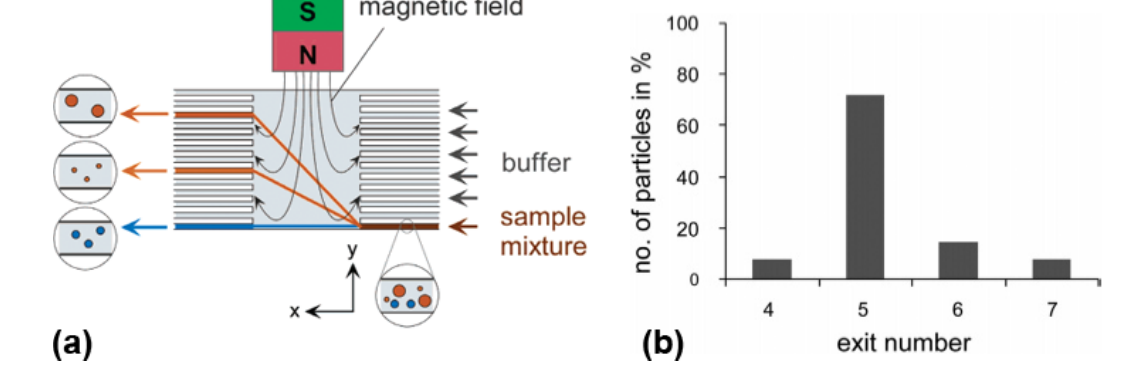
Figure 5. ( a ) Microfluidic separation of superparamagnetic particles in the presence of